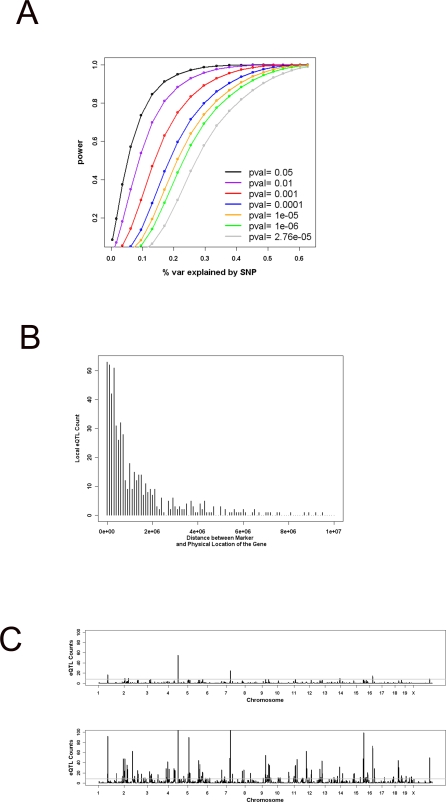
Power analysis and the genetic architecture of local and distant eQTL.Panel (A) shows the power calculation performed for genetic background effect of 0.3. Various curve colors represent the power associated with various p-value cutoffs. (grey = 0.05, green = 0.01, orange = 0.001, blue = 0.0001, red = 1e-05, purple = 1e-06, black = 2.76e-05 which is equivalent to the Bonferroni correction). For each calculation, the minor allele frequency is assumed 0.3. Panel (B) shows the distance of the association peak marker from the physical location of the gene for local eQTL identified in the MF1 population. Panel (C) shows the distant eQTL hotspots across the genome before (bottom) and after (top) population correction. The genome is represented as 1287 equally sized bins of 2 Mb. The gray line depicts the 0.05 genome wide significance for eQTL enrichment after Bonferroni correction (p-value of 3.9e-05).